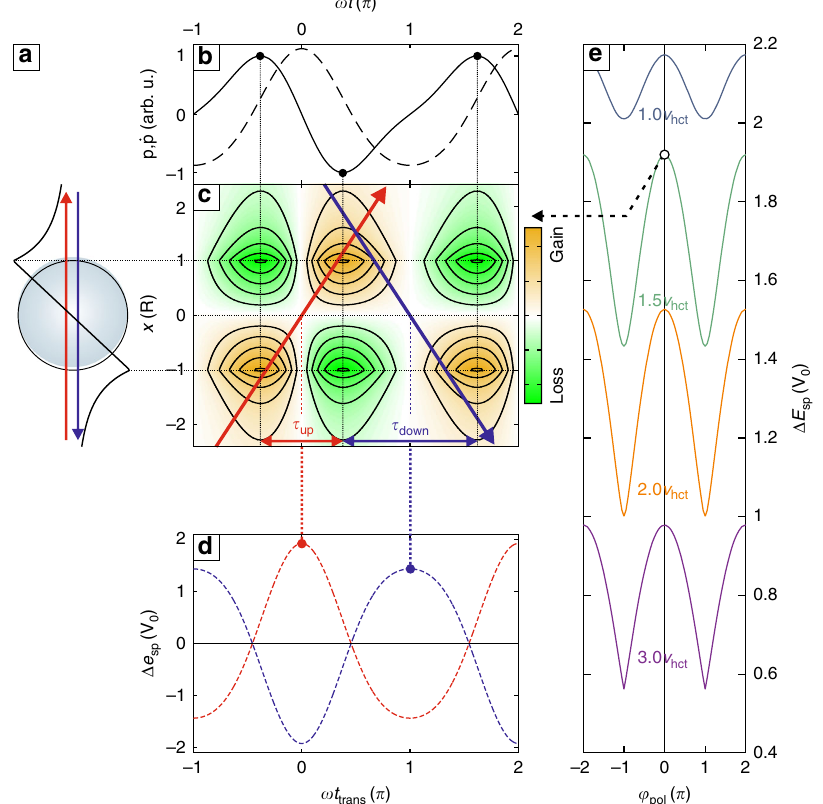
Fig. 3 Two-color nanoaccelerator model. a Schematics of scale-matched forward rescattering at a polarized sphere with potential V ( x , t ) = V pol ( x ) p ( t ), where V pol ( x ) is the static polarization potential (black curve) for unit dipole moment with amplitude V 0 . b Evolution of the two-color dipole moment p ( t ) (dashed curve) for a relative amplitude γ pol = 1/8 and corresponding dipole acceleration _ p t ð Þ (solid curve). c Resulting gain map ∂ ∂ t V ¼ V pol x ð Þ _ p t ð Þ with pronounced high-gain points (orange). Electron drift trajectories x ( t ) = ( t − t trans ) v d for optimal passages in up (red) and down (blue) direction for drift velocity v d = 1.5 v hct and relative dipole phase φ pol = 0. Corresponding transit times t trans are indicated as vertical dotted lines. Here v hct is the half cycle transit velocity (see text). d Transit time-dependent gain in the perturbative limit Δ E sp t trans ð Þ ¼ respective peak values (circular symbols) de fi ne the optimal trajectories. e Optimal gain for upward electrons vs. relative dipole phase φ pol for selected